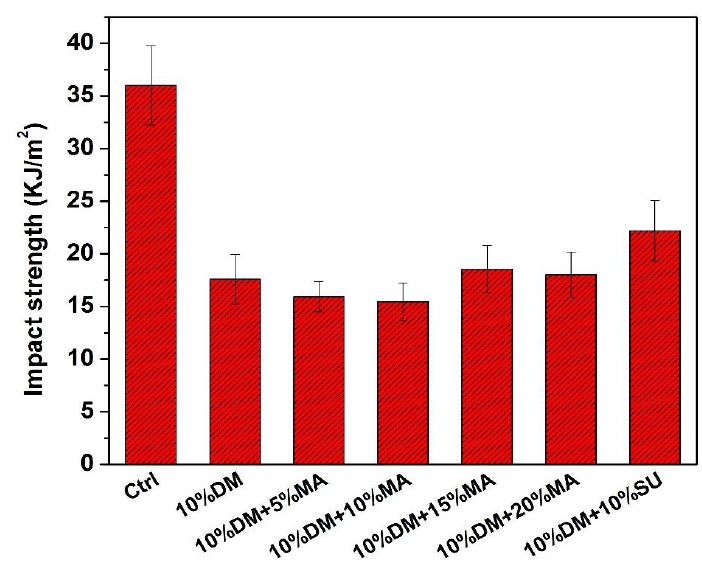
Figure 6. Impact strength of the sample treated with 10% DM, 10% DM and MA at different concentrations, and 10% DM and 10% SU. Table 4. Changes in the flexural and compressive of wood treated with different modifiers.